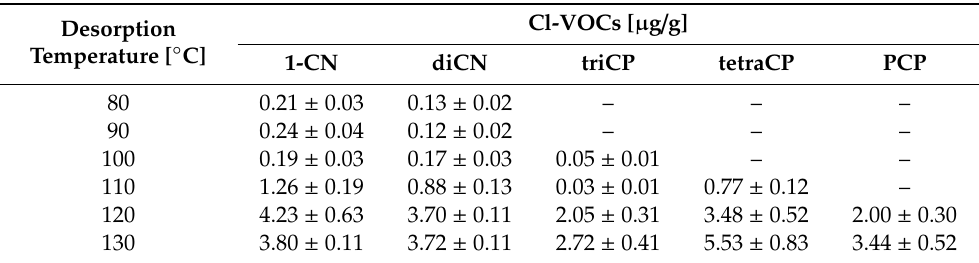
Emission of VOCs from wood samples impregnated with Xylamite, taken from a recreational house.